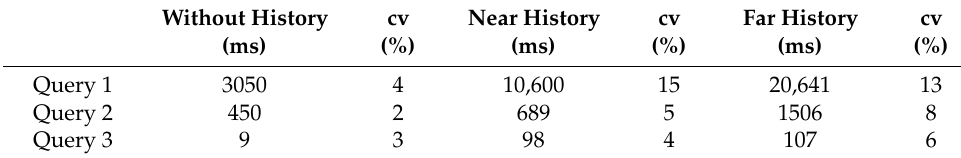
Table 6. Approach III: Query performance.